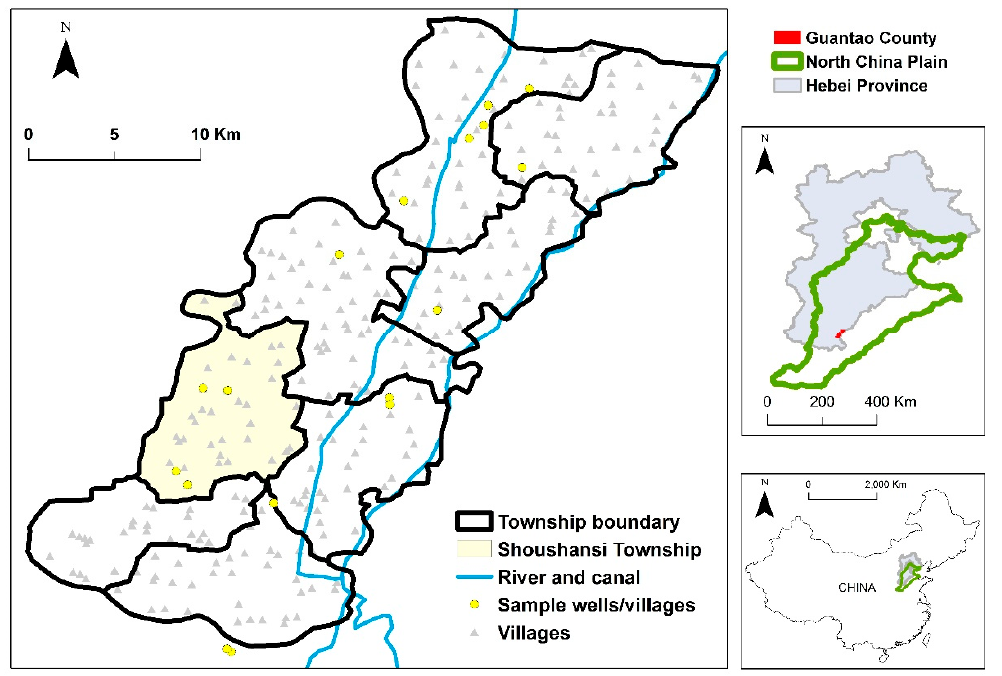
Figure 1. Location of Guantao County, with our focus area highlighted in yellow. The inset shows the North China Plain and Hebei Province.